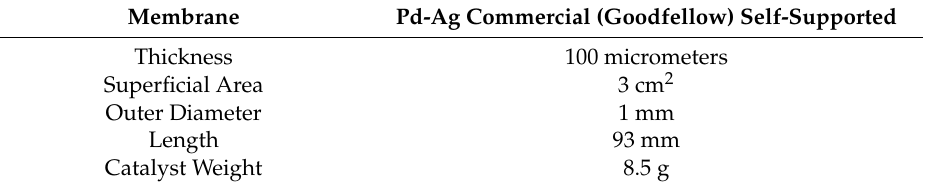
Figure 1. Membrane reactor scheme. Table 1. Membrane reactor characteristics.